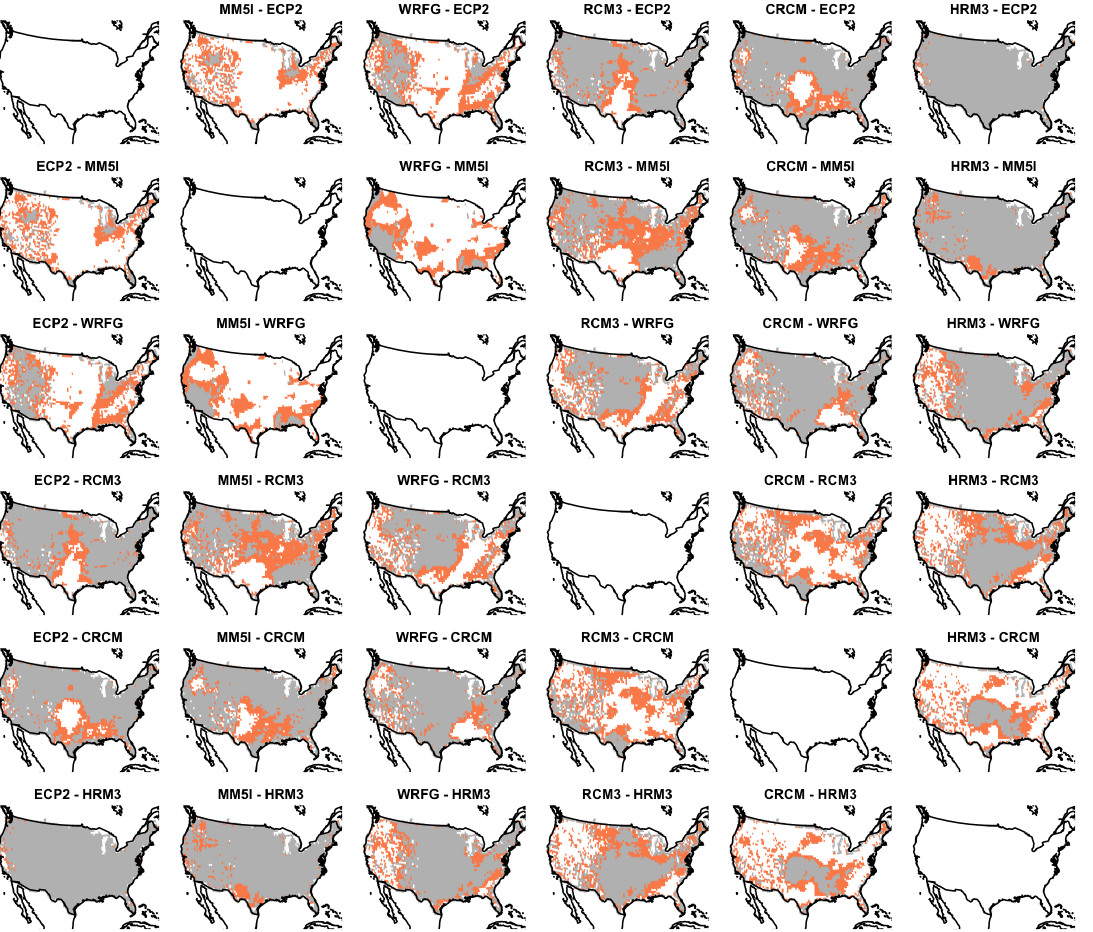
Figure A1. A comparison of the nonzero-effect regions of the average pairwise difference for RCM effects of the APL model using both pointwise and CoPE methods. The grey coloring indicates significant locations at the 0.10 level for both methods, while the orange coloring indicates that the effect is significant for pointwise inference